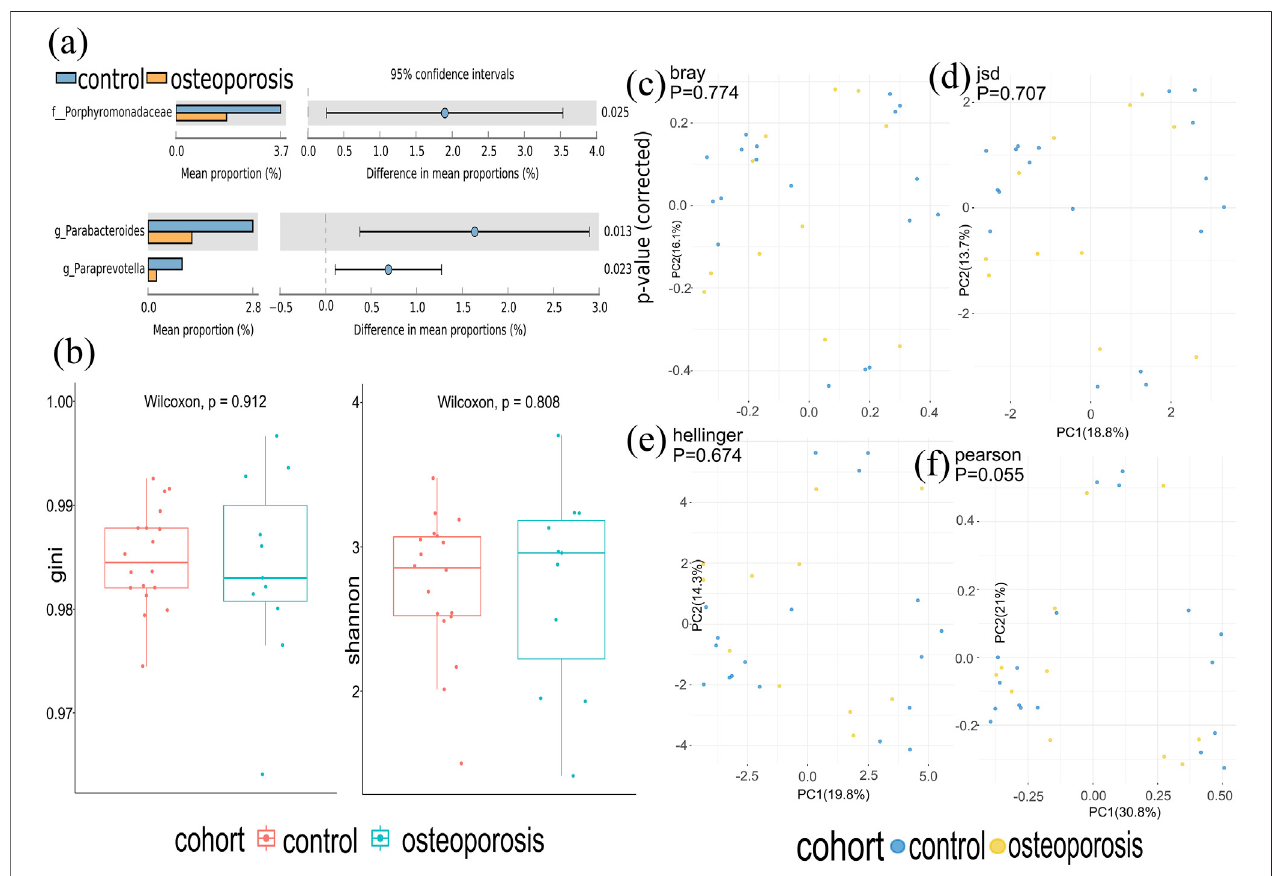
FIGURE 2 | Gut microbiota composition of osteoporosis (OP) and control groups. (A) Compared with the control group, relative abundances of Porphyromonadaceae,Parabacterodies,andParapreotellaweredecreasedintheOPgroup( p < 0.05).Therewerenosigni fi cantdifferencesinthephylaoftheOPgroup comparedwiththecontrolgroup( p > 0.05). (B) AlphadiversitywasmeasuredbybothShannonandGiniindicesforcomparisonsbetweenOPandcontrolgroups. (C – F) Beta diversity between OP and control groups. Beta diversity wascalculated by Hellinger, Jensen – Shannon divergence (JSD), Bray, and Spearmen distances. No signi fi cant differences were found between the OP and control